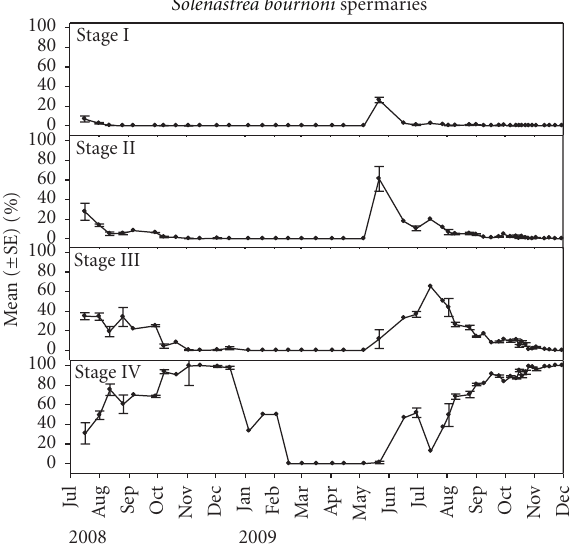
Figure 3: Solenastrea bournoni mean ( ± SE) percentage spermary stages per colony quantified through histological examination.